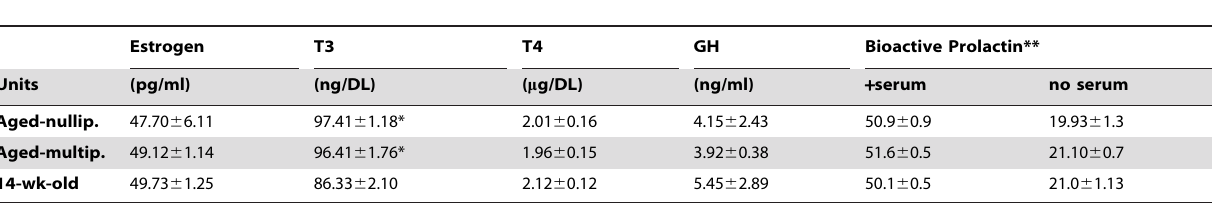
Serum was collected from 14-wk-old females, aged-nulliparous and aged-multiparous females and analyzed for the indicated hormones as described in Materials and Methods. No significant difference was observed in the serum levels of estrogen, thyroxin (T4), growth hormone (GH) or bioactive prolactin. Triiodothyronine (T3) was significantly higher in serum samples of the aged-nulliparous (* P , 0.05) and aged-multiparous mice (* P , 0.05 ) than the 14-wk-old control mice. *= P , 0.05 vs. 14-wk-old. **Serum levels of bioactive prolactin are measured in ng/ml.